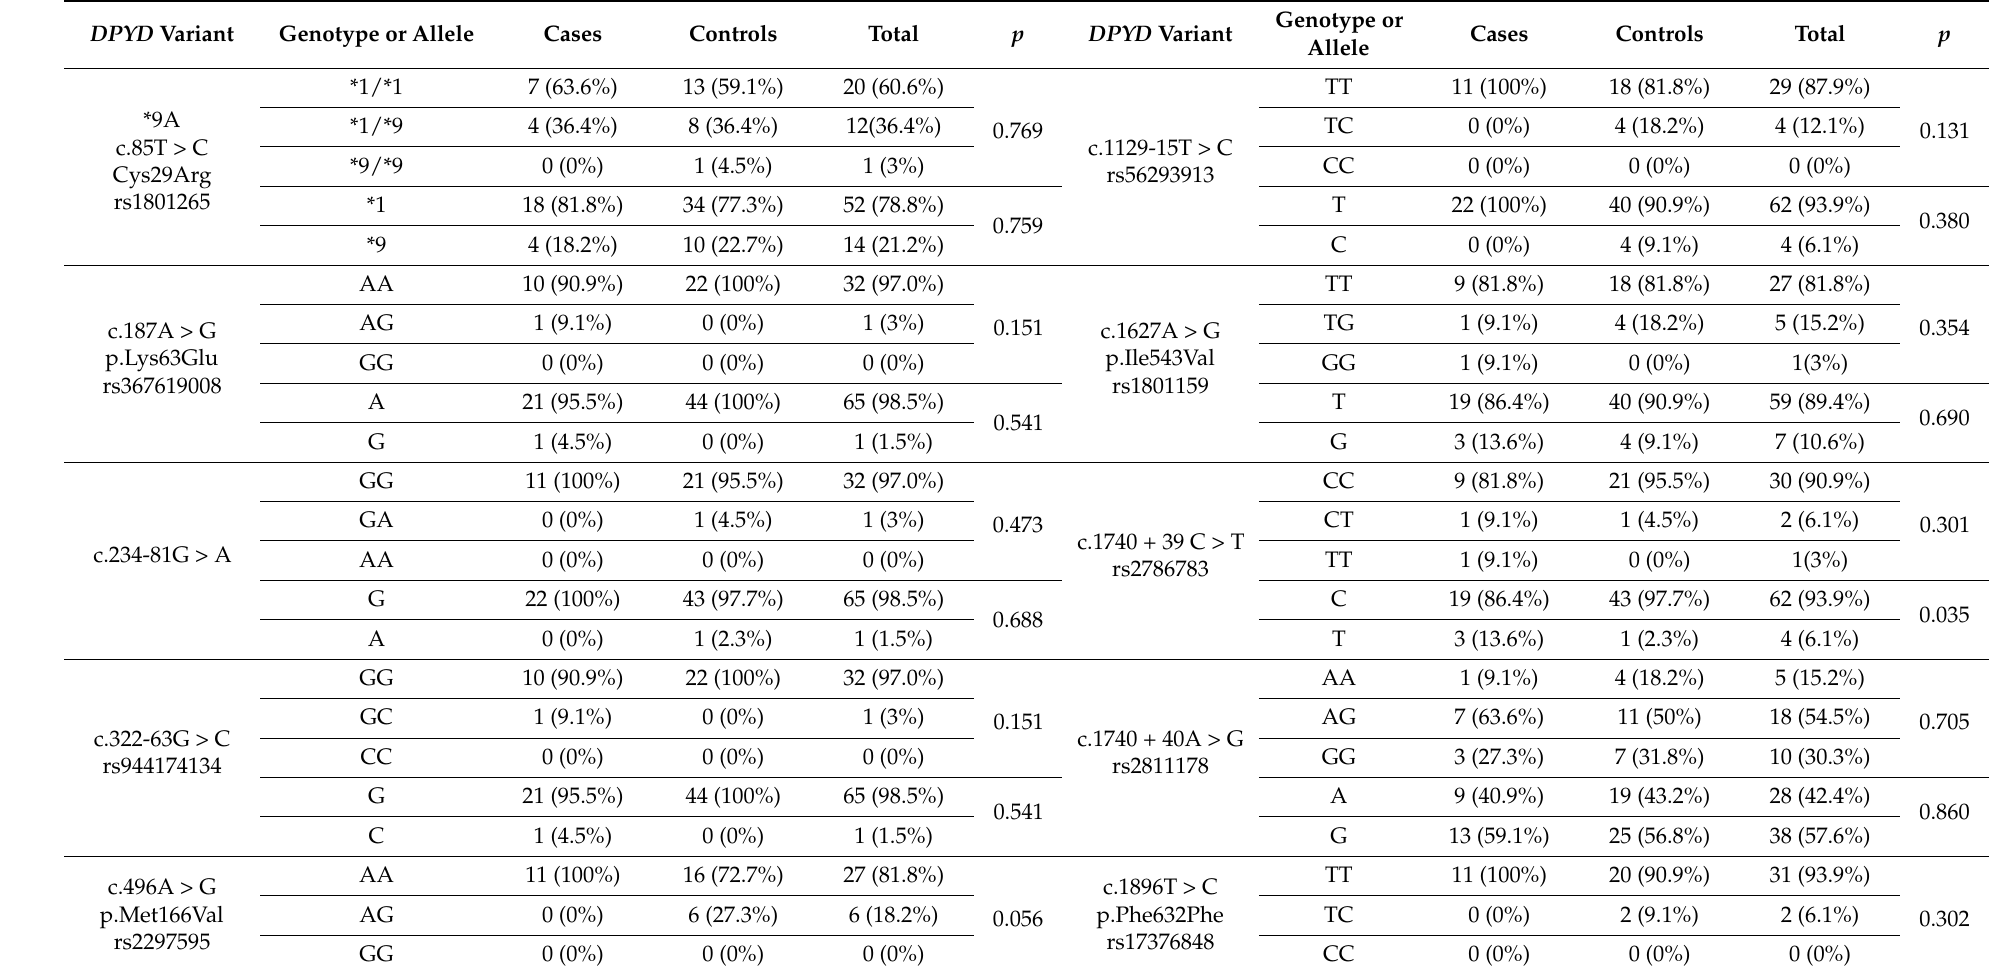
Table 4. Genotype and allele frequencies of the identified DPYD variants among cases and